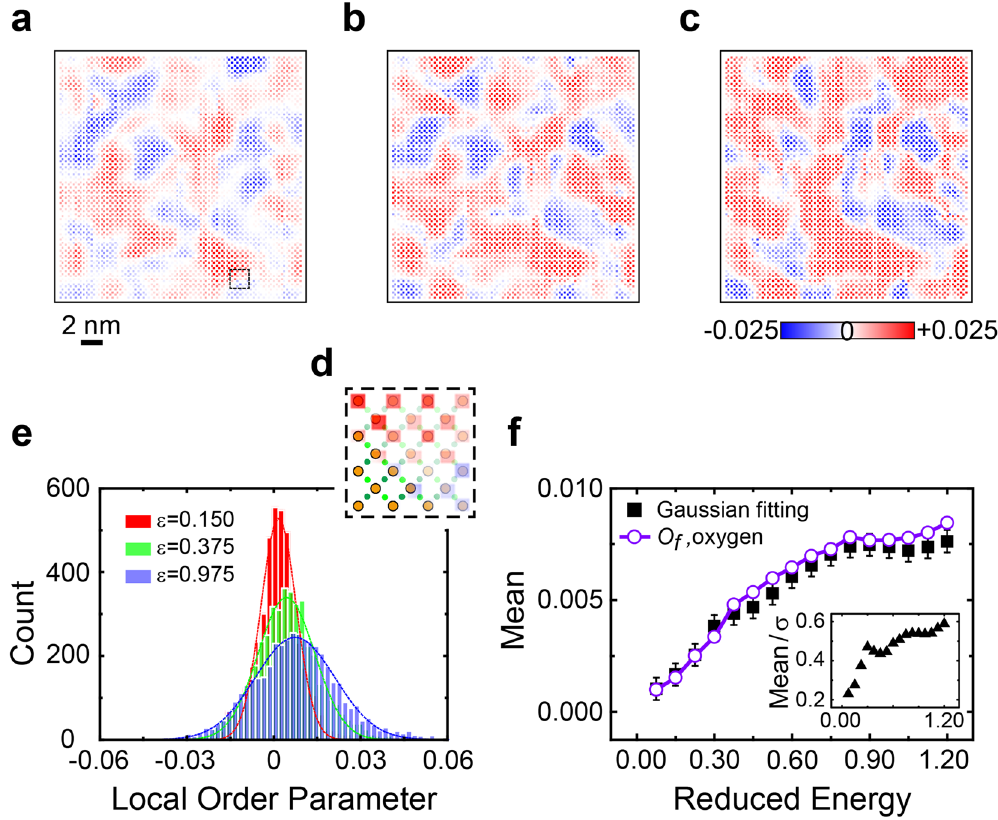
Figure 4. Distribution of Local nematic orders. Maps of cell order parameters O f ( n , ε ) in the real space with the reduced energies of ( a ) ε = 0.150, ( b ) ε = 0.375, and ( c ) ε = 0.975. ( d ) The magnification of the selected region in ( a ). The positions of Cu and O atoms are shown in the left corner, while the cell order parameters of unit cells are retained in the rest part. ( e ) Histograms of the cell order parameters from panels a–c with the bin size = 0.001. Each histogram is fitted by a dashed line of the Gaussian distribution. ( f ) The mean (filled squares) δ O f and ratio between the mean and relative standard deviation (filled triangular in the inset) of the Gaussian fitting as the function of ε . The error bar due to the bin size is shown for each mean of the Gaussian fitting. The collective order parameters O f ( ε ) (open circles) in Fig. 2e are provided for → cell nematic order parameter O f (n , ε ). The image resolution of O f (n , ε ) is reduced compared to that of ε Z r ( , ) , as the information of each unit cell is compressed into a single pixel. Three typical cell order parameter maps with ε = 0.150, 0.375, and 0.975 are displayed in Fig. 4a–c, to demon- strate the evolution of O f ( n , ε ) with the change of the reduced energy, while the full evolution is provided in Supplementary Fig. S3. At each reduced energy, the order parameter map is inhomogeneously distributed. Both positive and negative nematicities form nanoscale domains, which are depicted in red and blue colors in Fig. 4a– c. For a small reduced energy ( ε = 0.150, in Fig. 4a), these two opposite nematic domains occupy roughly the same percentage of the image, leading to nearly zero collective nematicity. With the increase of the reduced energy, the colors of both domains are intensified so that the local nematicity is enhanced. In our selected FOV, the average strength of the positive nematicity however experiences a stronger enhancement than that of the negative nematicity. At the same time, the size of red domains grows, showing a gradual formation of the collec- tive positive nematicity. For example, a blue domain at the top left corner of Fig. 4a is cut into two parts and a red domain emerges in Fig. 4b when the reduced energy changes from 0.150 to 0.375. On the other hand, the major domain structure is considerably preserved. With the Ising symmetry x n = ± 1 assigned to a red or blue pixel for , is used to quantitatively describe the each unit cell, a correlation function, = ∑ − ′ n n n structural difference between the images of local order parameters at two different reduced energies. A similarity over 75% is found between Figs 4a and b. As the reduced energy further approaches the PG energy level ( ε = 0.975, in Fig. 4c), both the size increase of red domains and the color intensification of the two domains slow down, since the cell and collective nematic orders start to be saturated. The electronic structure in overdoped Bi-2201 follows a smooth transition of symmetry breaking, and a nanoscale disorder is frozen during the estab- lishment of the nematicity. To gain a more quantitative description of the site-specified nematicity, we draw a histogram of O f ( n , ε ) for each reduced energy ε by counting O f ( n , ε ) over a selected bin size δ O f = 0.001. In Fig. 4e, the histograms resulted from Fig. 4a–c are plotted, each being well fitted by a Gaussian envelope,